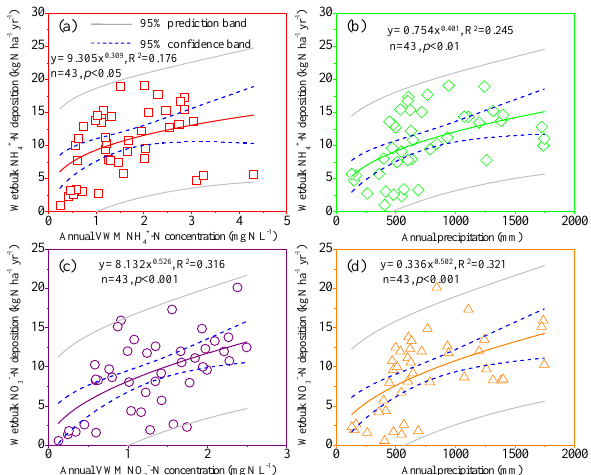
Figure 8. Correlations between annual wet/bulk NH + tion and annual volume-weighted concentration of NH + annual precipitation (b) ; between annual wet/bulk NO − tion and annual volume-weighted concentration of NO − annual precipitation (d)